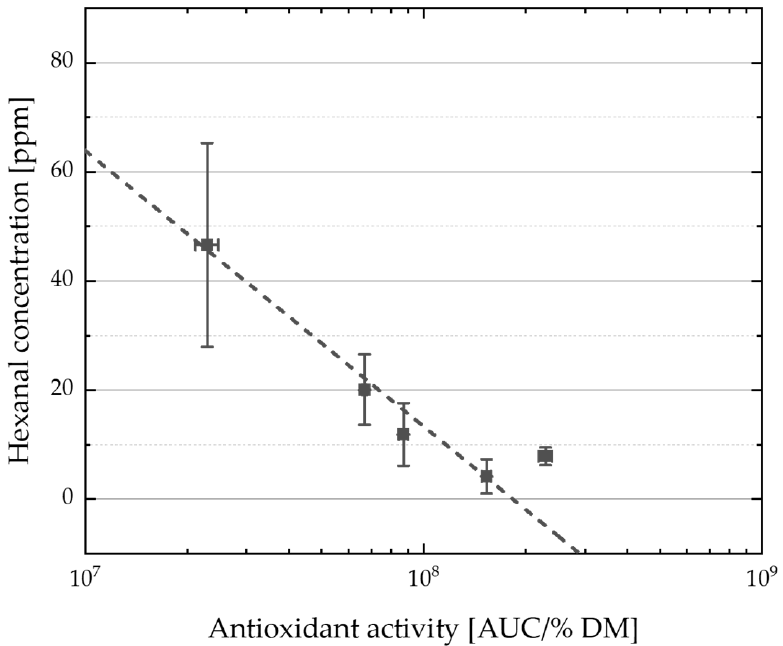
mean values ( n = 3) with linear equalization function (R 2 = 0.99) for all samples stored in light. the daily oxygen consumption rate in mg O 2 per 100 g per day for the emulsions with extract, as